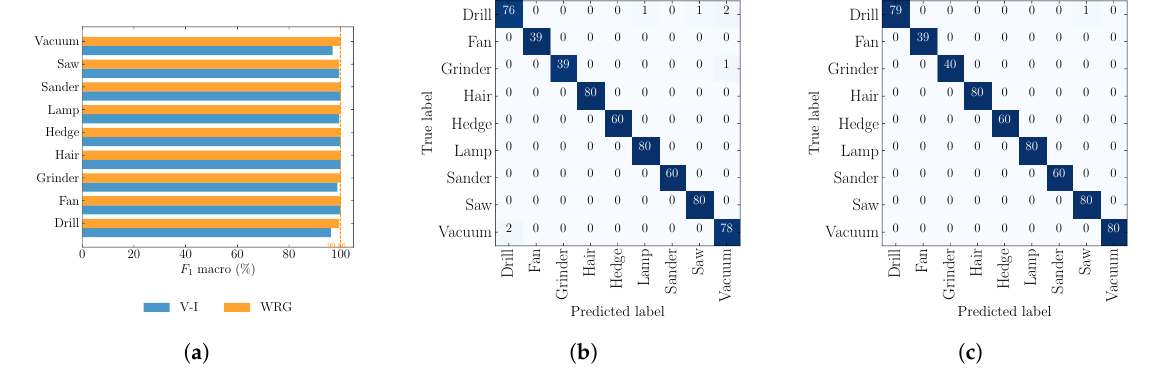
Figure 7. The F 1 macro (%) matrix per appliance and confusion matrix for the COOLL dataset: ( a ) F 1 macro (%) for V–I and WRG; ( b ) V–I confusion matrix; ( c ) WRG confusion matrix.